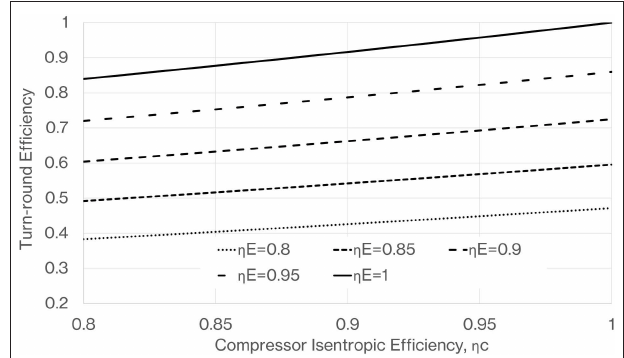
FIGURE 5 | Turn-round efficiency as a function of compressor and expander isentropic efficiencies, calculated using Equation (8) with pressure ratio of 20 and ratio of specific heats for a monatomic gas such as